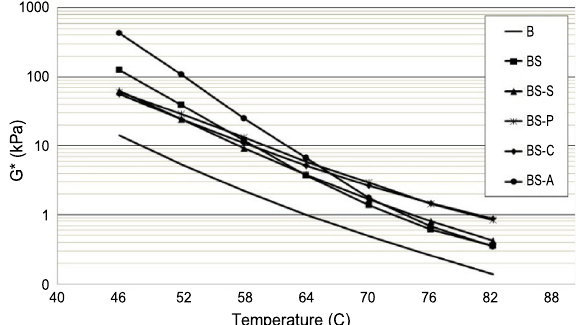
Table 8. The effect of sasobit on the viscosity of base and modified bitumen